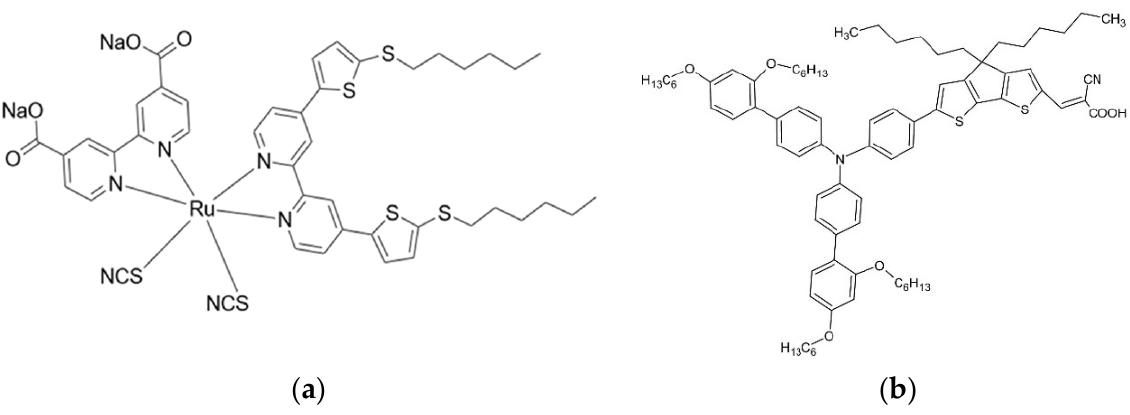
Figure 1. Molecular structure of ( a ) C106 dye and of ( b ) Y123 dye.